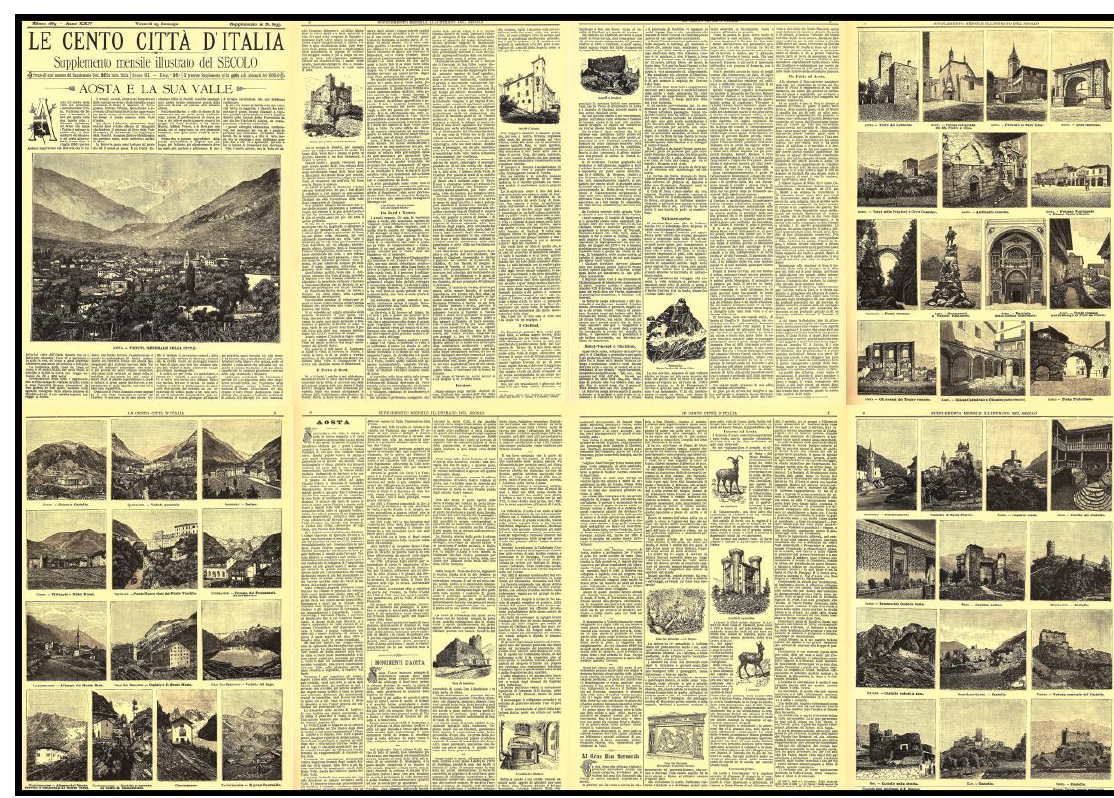
Figure 4. Aosta e la sua valle issue